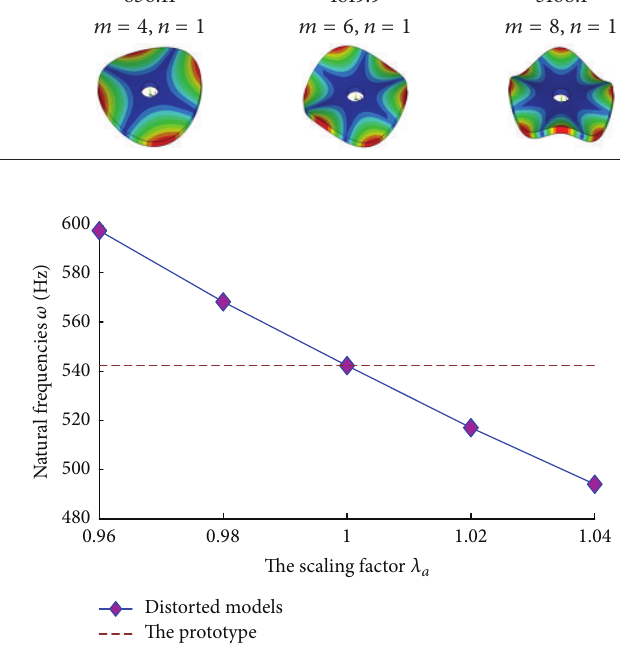
Figure 3: The fitted curve of outer radius distorted